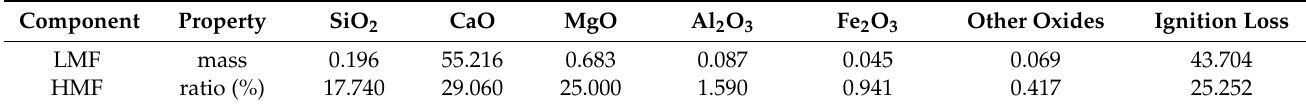
Table 1. XRF results of LMF and HMF.